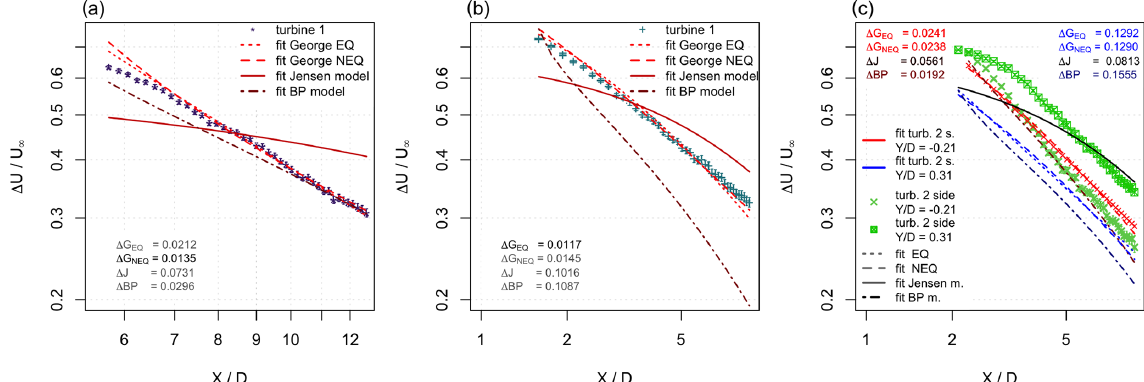
Figure 13. Modeled (cid:49)U/U ∞ for the three different inflow conditions at the spanwise position Y/D = − 0 . 21: (a) turbine 1 – laminar inflow, (b) turbine 2 mid – turbulent, and (c) turbine 2 side – turbulent and intermittent. Different models are fitted to the recovery region, and the residual standard errors are presented. Note that the axes are logarithmic.